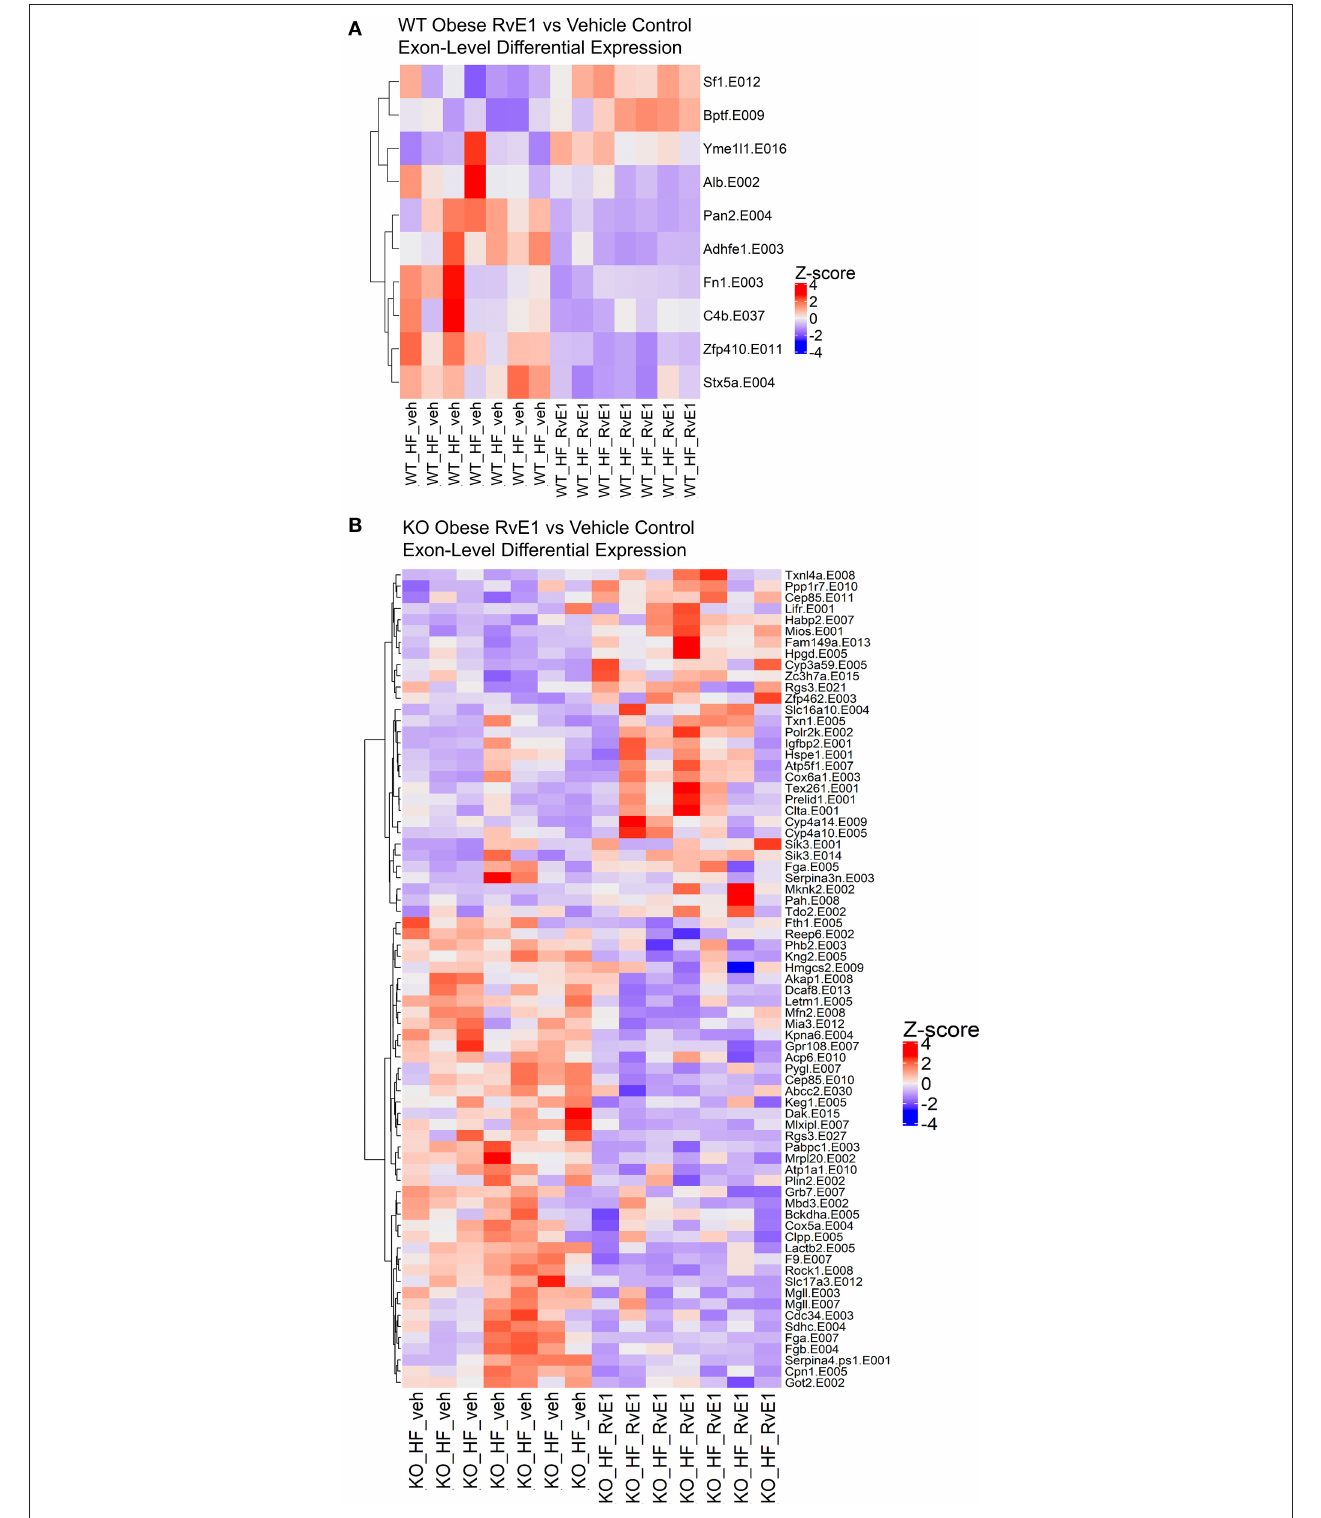
FIGURE 4 | RvE1 controls transcriptional regulation and expression at the exon level. (A) Heatmap of differentially expressed exons between WT obese + RvE1 treated mice and WT obese + vehicle control treated mice. (B) Heatmap of differentially expressed exons between ChemR23 KO obese + RvE1 treated mice and ChemR23 KO obese + vehicle control treated mice. Data are from 7 mice per